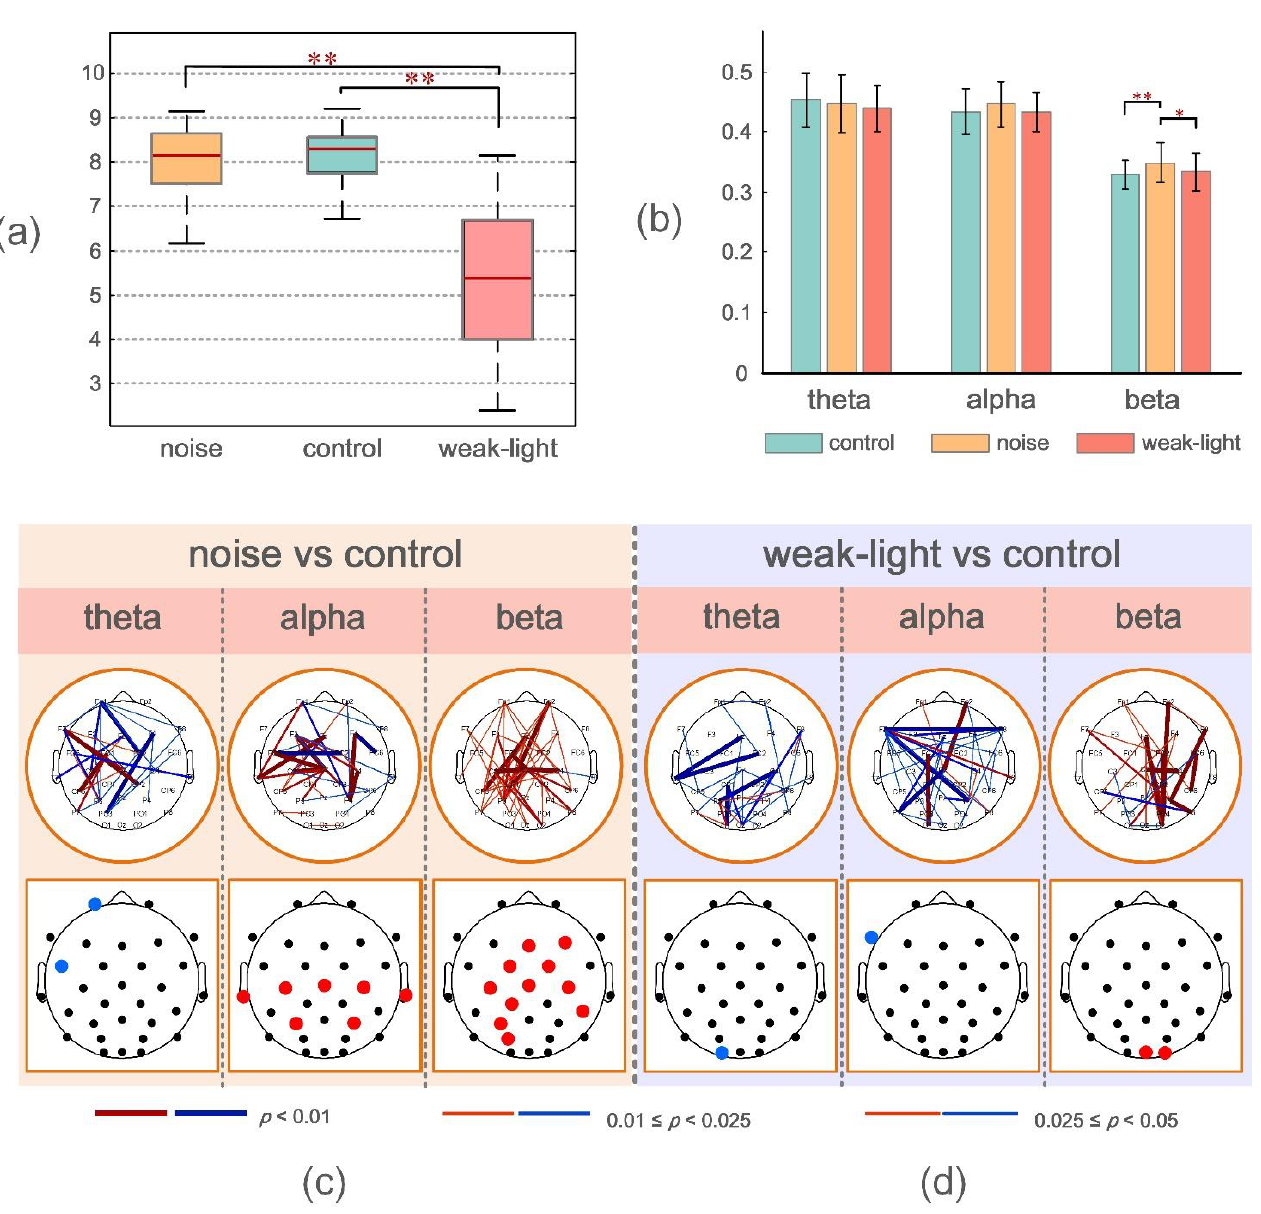
Figure 2. ( a ) From left to right, the mean, the standard deviation of the mean scores of the noise group, the control group, and the weak-light group. * p < 0.05 indicates a significant difference in topological characteristics; ** p < 0.01 indicates a very significant difference in topological characteristics. ( b ) Mean and standard deviation of the mean WPLI values during shooting aiming at theta, alpha, and beta frequency bands in the control, noise, and weak-light groups. The vertical axis in the figure represents the functional connectivity strength, and the error bars represent the standard deviation. ( c , d ) represent the connection and electrode positions where the WPLI connection values of each channel and the average WPLI connection values of each node in the noise and weak-light groups are significantly different from those in the theta, alpha, and beta bands of the control group, respectively. The black nodes in the figure represent the electrode positions. The colored connections and nodes indicate a statistically significant ( p < 0.05) difference between the connection in the different leads. Red/blue in the figure represent the connections and nodes in the experimental group (noise group, weak-light group) with higher/lower connection values than those in the control group. The color bar indicates statistically significant differences in connection values.